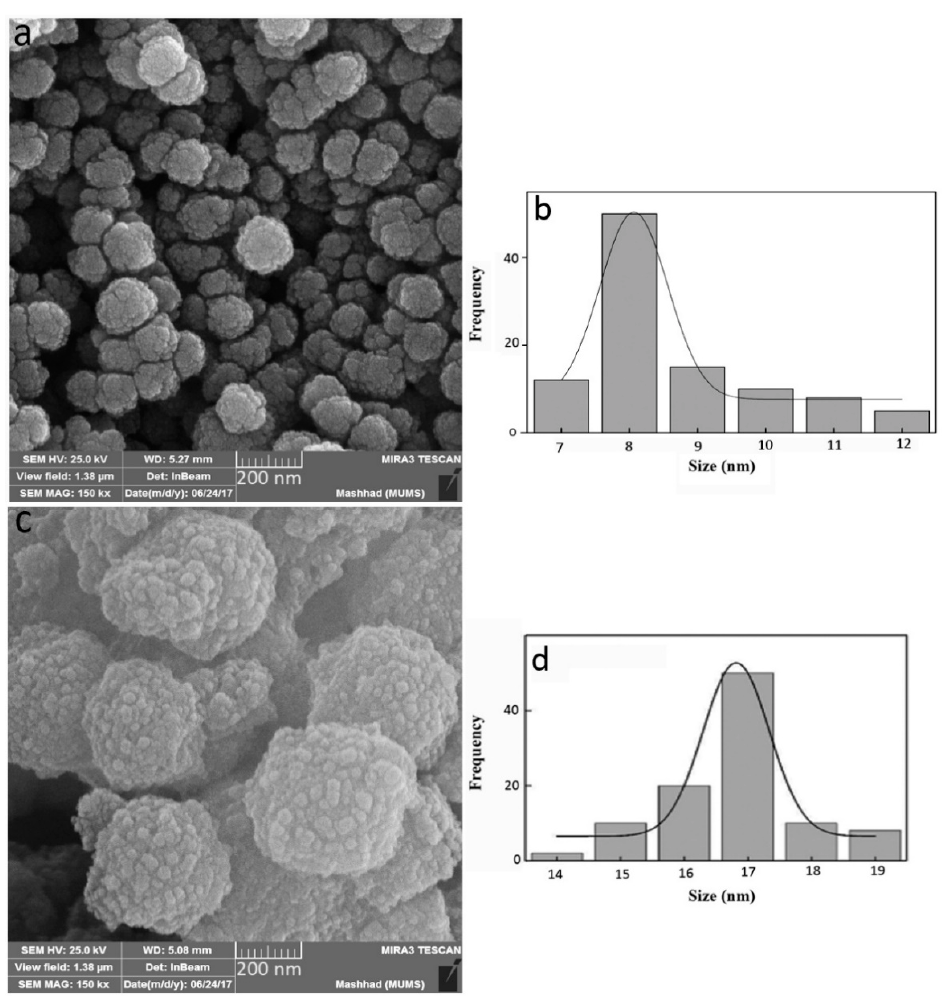
Figure 2. ( a , b ) SEM images and size distribution of the synthesized CoNiFe sample, respectively; ( c , d ) SEM images and size distribution of the synthesized CoNiZn samples, respectively.